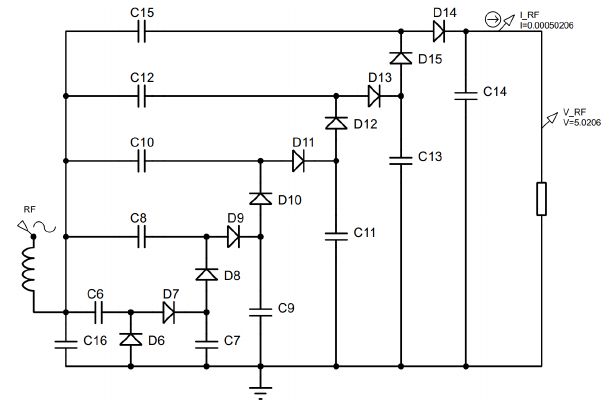
Figure 5. The 5-satges of the voltage multiplier The voltage multiplier (VM) is utilized to amplify the power and also convert the AC harvesting voltage of the antenna to the DC voltage. Depending on the input and desired output voltage, the VM is used with di ff erent stages while each stage consists of two diodes and two capacitors. The number of the stages is directly proportional to the output voltage of the VM and the delay time to approach the target. This drawback is the trade-o ff between the number of the stages leading of increasing the diodes and the dissipate the power at each stage which is caused by diodes [20, 21]. Hence, we choose 5-stages VM relying on our desired voltage and the delay time in this paper, designed as shown in Fig.